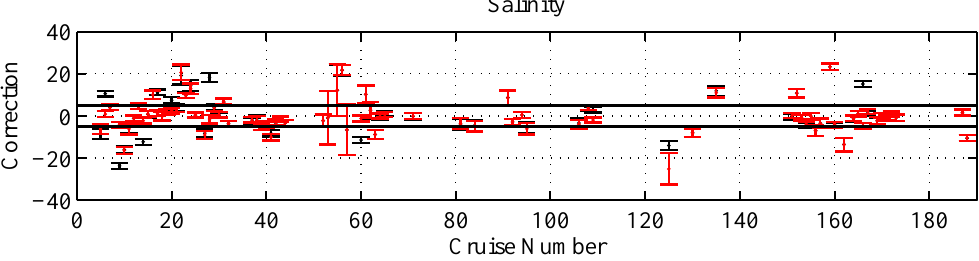
Figure 4 Figure 4. Corrections for the CARINA-ATL salinity data as suggested by two WDLSQ inversions. The black symbols are results obtained using original (i.e. unadjusted) data; the red symbols are obtained using the adjusted data set. The black horizontal lines denote the threshold of 5ppm, no smaller adjustments were applied to the data.